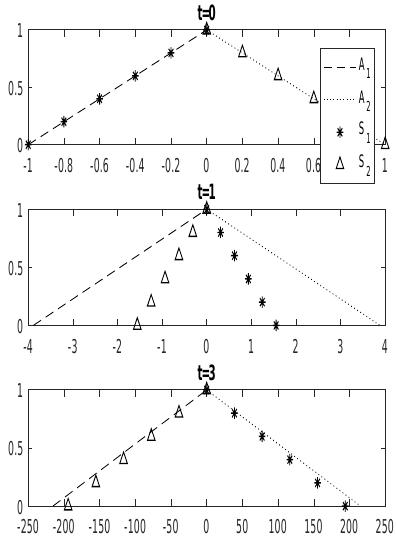
Figure 8. Line graph for differential Equation (7) with FICs.